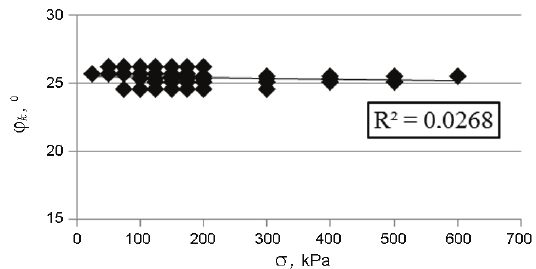
Fig. 19. The angle of internal friction versus vertical stress (results of 33